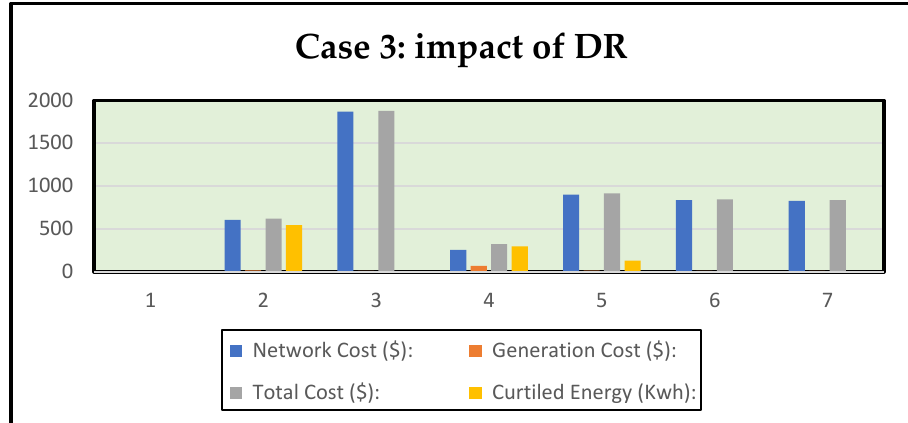
Figure 21. Overall response of Case 3.